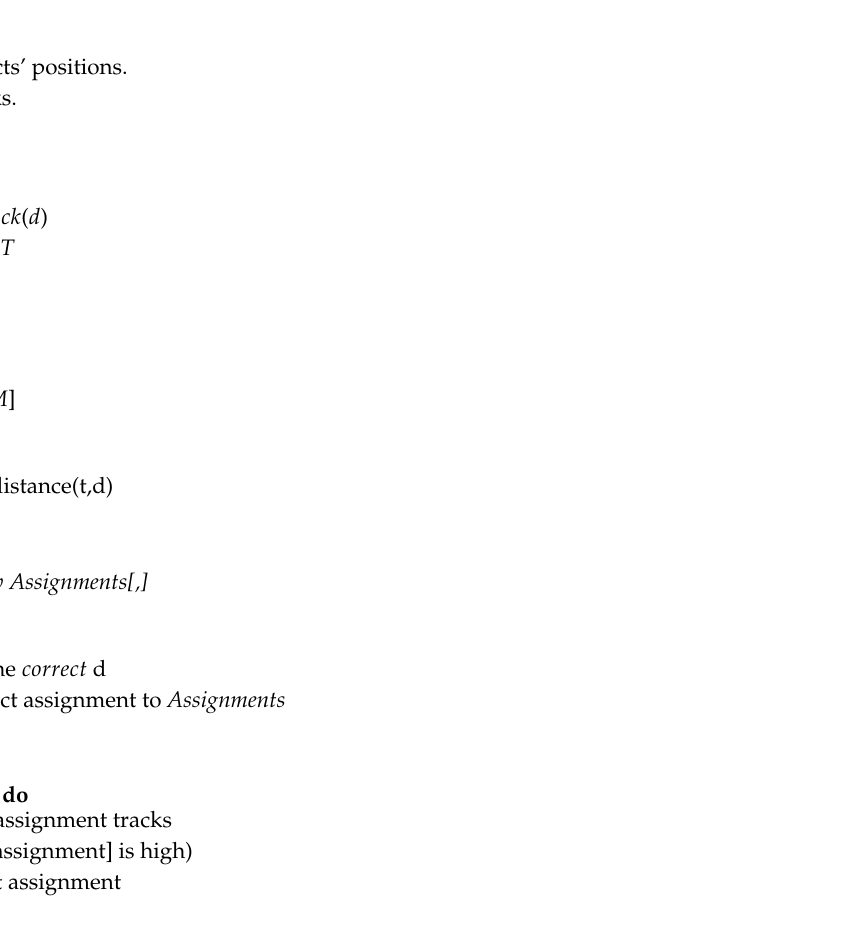
Algorithm 1: Multi-object tracking update